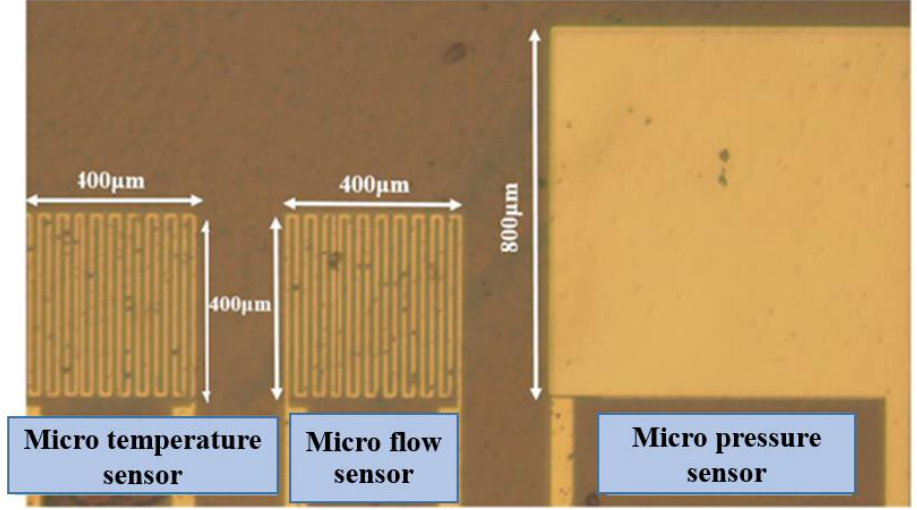
Figure 2. Optical micrograph of flexible three-in-one microsensor size and layout.